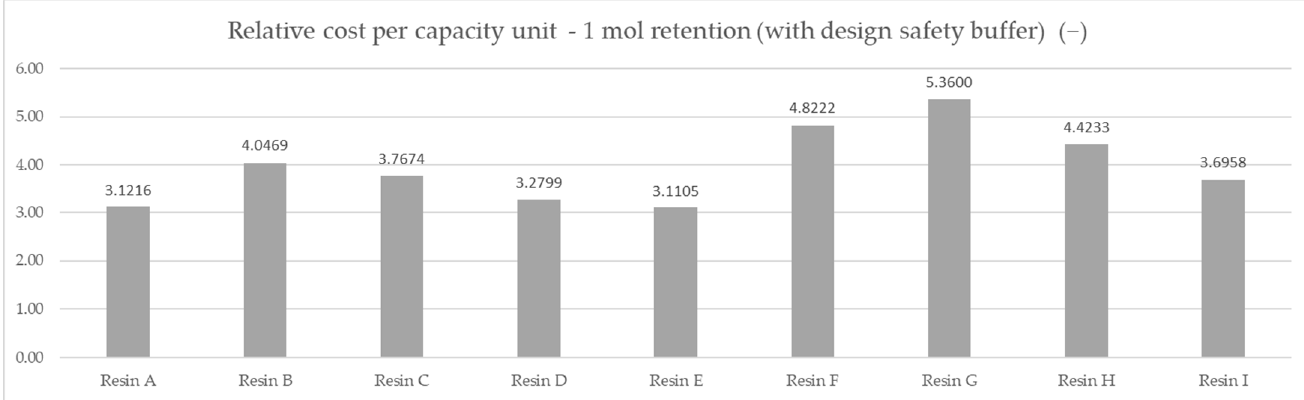
Figure 11. Comparison of the relative cost of the calculated average mmol capacity unit, corrected for behavioral differences—DAP price of 1 mol capacity under the applied set testing conditions, three standard deviations’ correction according to Six Sigma methodology.